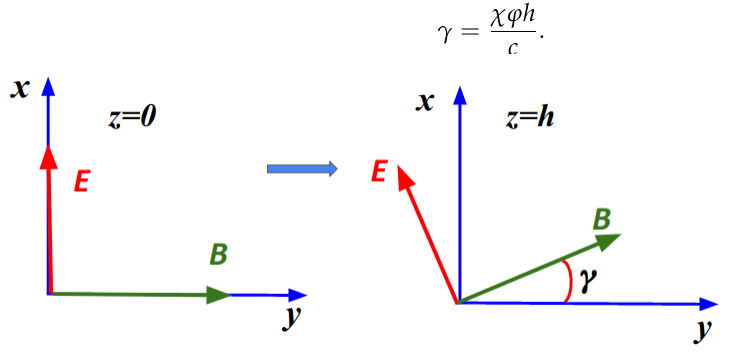
Figure 1. Faraday effect of polarization rotation under the action of uniform axial